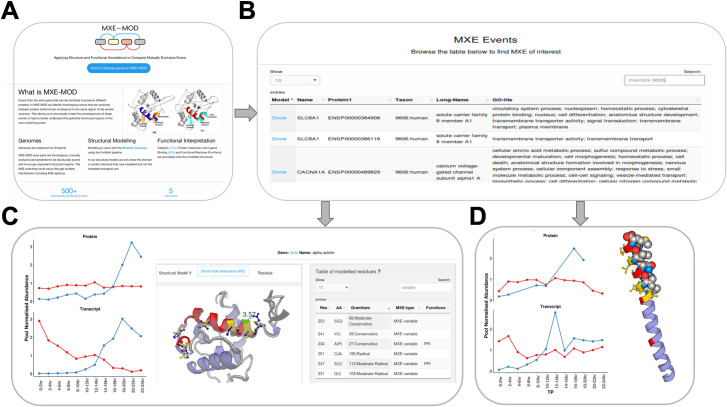
MXE-MOD Website.(A) The home page of MXE-MOD website. (B) The browser view allows the user to search different organisms and find a particular gene of interest. Annotations for the gene and associated MXE event have been integrated from different public resources: CATH, GENEONTOLOGY, Human Protein Atlas, DRUGBANK and Ensembl [31,46–49].(C-D) Detailed ‘MXE model’ pages for 2 different examples in the website. We can see the alternative MXE structure superposed in (C). We can see the variable PPI residues shown in space fill in the website in (D). MXE-MOD utilises the PV javascript viewer [50]. For both examples we show the expression patterns for the MXE isoform groups at different stages of development from RNA-seq and proteomics derived datasets. RNA-seq data is obtained from ModEncode resource [51] and proteomics data from the DDIP consortium (https://ddip-proteome.org) led by Simon Hubbard, Manchester University, UK.